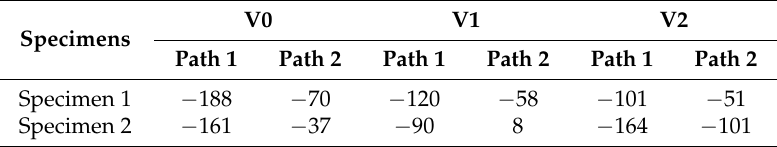
Table 2. Transversal residual stresses measured at the weld toe in MPa.